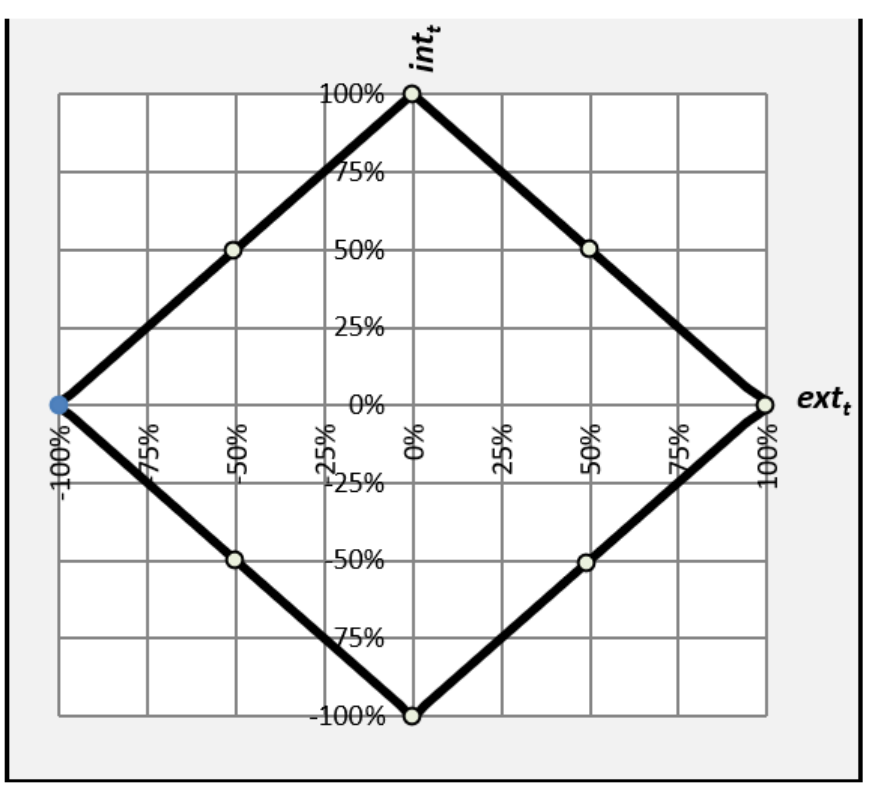
Figure 5. Combination of all possible values of dynamic intensity or extensity indicators according to Equations (34) and (35).